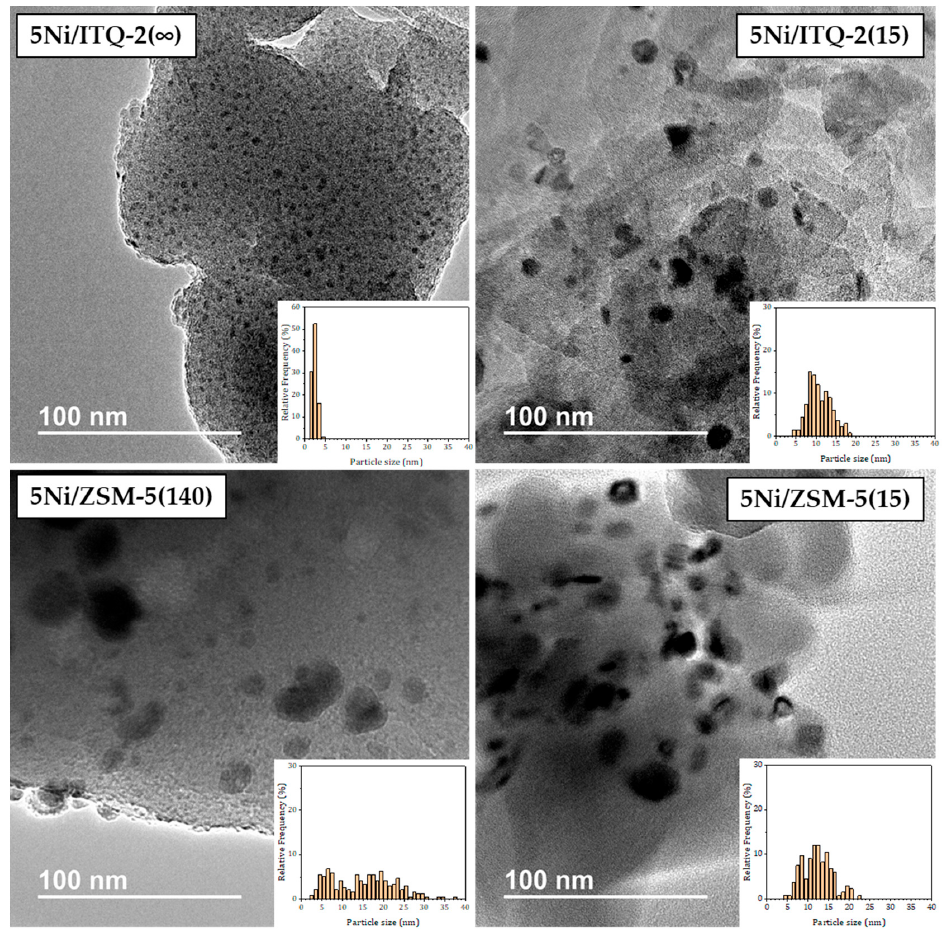
Figure 3. HR-TEM images and Ni 0 particle size distribution of the 5 wt.% Ni catalyst supported on ITQ-2 and ZSM-5 with di ff erent Si / Al ratios. Images correspond to reduced fresh catalyst before the methanation